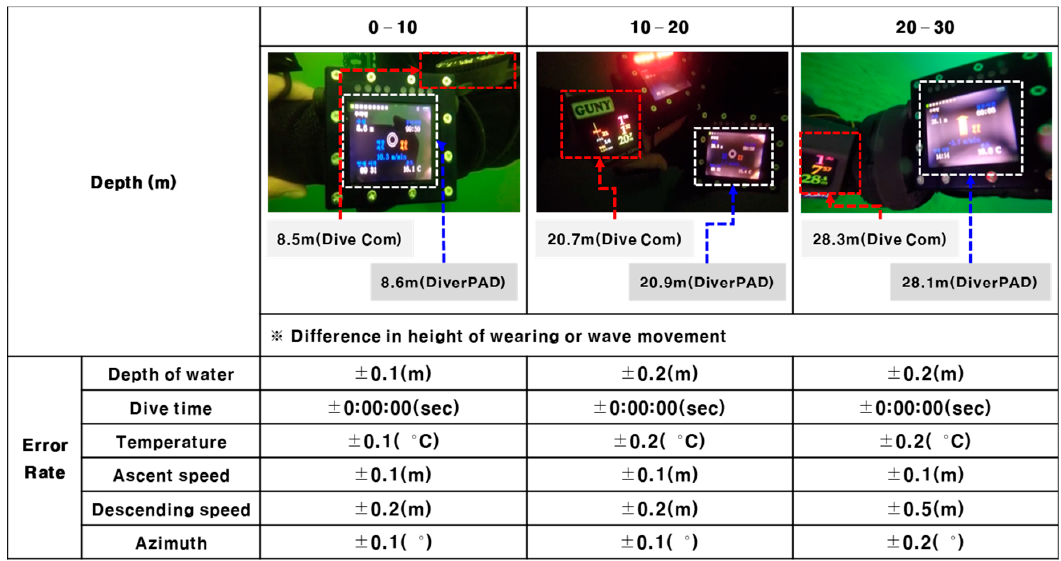
Figure 11. Test conditions of DiverPAD.